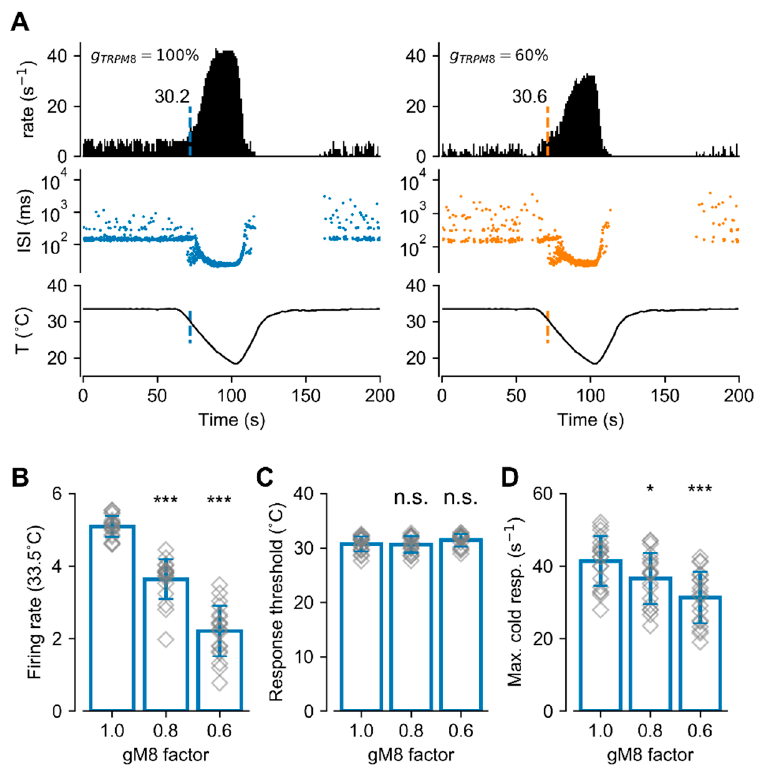
Figure 7. Mathematical model of cold-sensitive nerve endings with different I TRPM8 densities. ( A ) Simulated activity of the model exposed to the temperature trace depicted at the bottom, with normal (100%, left) and reduced (60%, right) TRPM8 conductance density. The top row shows the firing rate (spikes/s) and the middle row shows the inter-spikes intervals (ISI; log scale). The vertical colored line shows the moment and the temperature at which the firing rate exceeds the mean plus 3 times the standard deviation of the basal activity (thermal threshold). ( B ) Firing rate at 33.5 °C for 19 sets of parameters (different corneal neurons) (see Table 1), with different densities of TRPM8 conductance. For each model, the normal density of TRPM8 maximal conductance ( gM8 factor = 1.0) is the density that gives a firing rate around 5 spikes/s. ( C ) Temperature threshold for cold-evoked activity increases in the same simulations shown in ( B ). ( D ) Maximum firing rate during the cold pulse, for the simulations shown in ( B , C ). In ( B – D ), bars represent the mean (±S.D.), and the symbols show the individual data. Each data point is the average of 8 independent simulations with the same set of parameters. * p < 0.05, *** p < 0.001 and n.s. p > 0.05, when compared to the gM8 factor = 1 condition (Unpaired Student’s t -test).